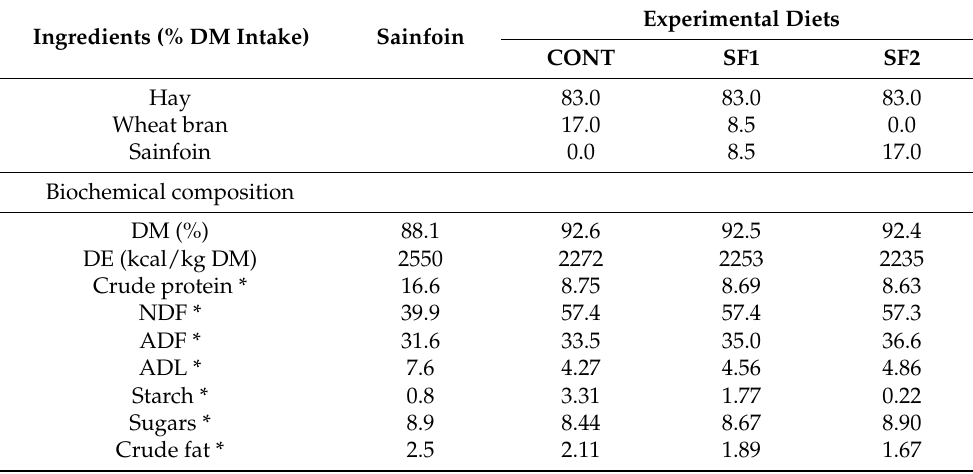
Table 2. Composition of sainfoin and experimental